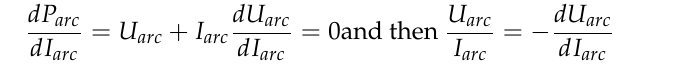
13 of 21 Figure 7. Analytically calculated choke current ( a ), mains voltage and network current ( b ) [31]. R e a c t o r c u rr e n t , A